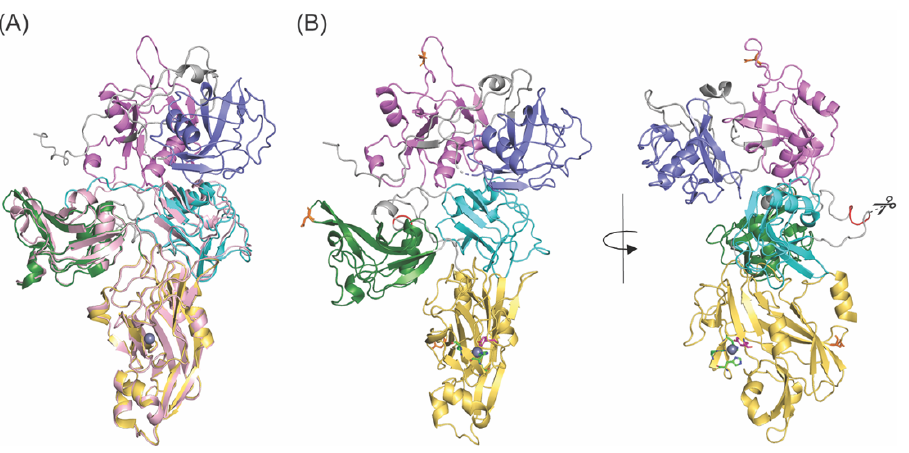
Figure 7. Structure prediction of fl-LOXL2. ( A ) Overlay of 3D structure of fl-LOXL2 predicted by AlphaFold ver 2 (SRCR1 in slate, SRCR2 in purple, SRCR3, SRCR4, amine oxidase domain in lightpink) and X-ray crystal structure of ∆ 1-2SRCR-LOXL2 (SRCR3 in cyan, SRCR4 in green, amine oxidase domain in yellow). Zn 2+ occupying the Cu 2+ -binding site is shown as a gray sphere. ( B ) 3D structure of fl-LOXL2 predicted by AlphaFold ver 2 (SRCR 1 in slate, SRCR in purple, SRCR3 in cyan, SRCR4 in green, amine oxidase domain in yellow) in two angles. The PACE4 cleavage site ( 314 Arg- 315 Phe- 316 Arg- 317 Lys- ↓ 318 Ala) is highlighted in red. The N -glycosylation sites (Asn288, Asn455, Asn644) are in orange stick. Peptides connecting domains are in